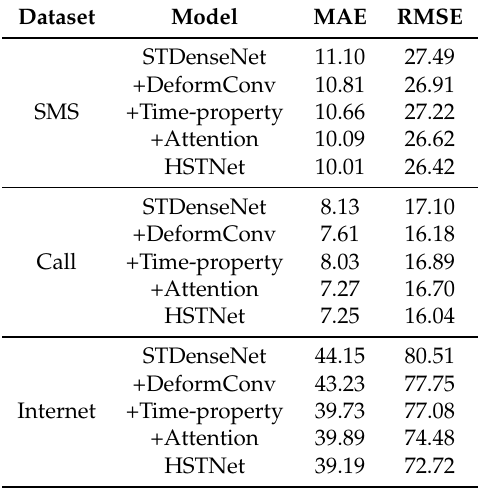
Table 1. Overall performance of the